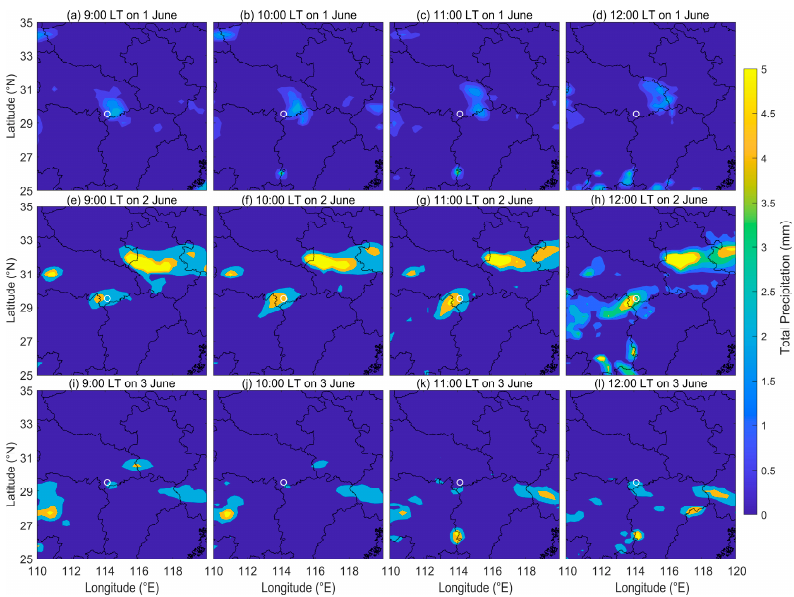
Figure 2. Regional distribution map of the rainfall (ERA 5 data). The data at 9:00–12:00 LT are listed from left to right columns, and the data on 1–3 June 2015 are listed from top to bottom rows. The white circle presents the location of the Wuhan MST